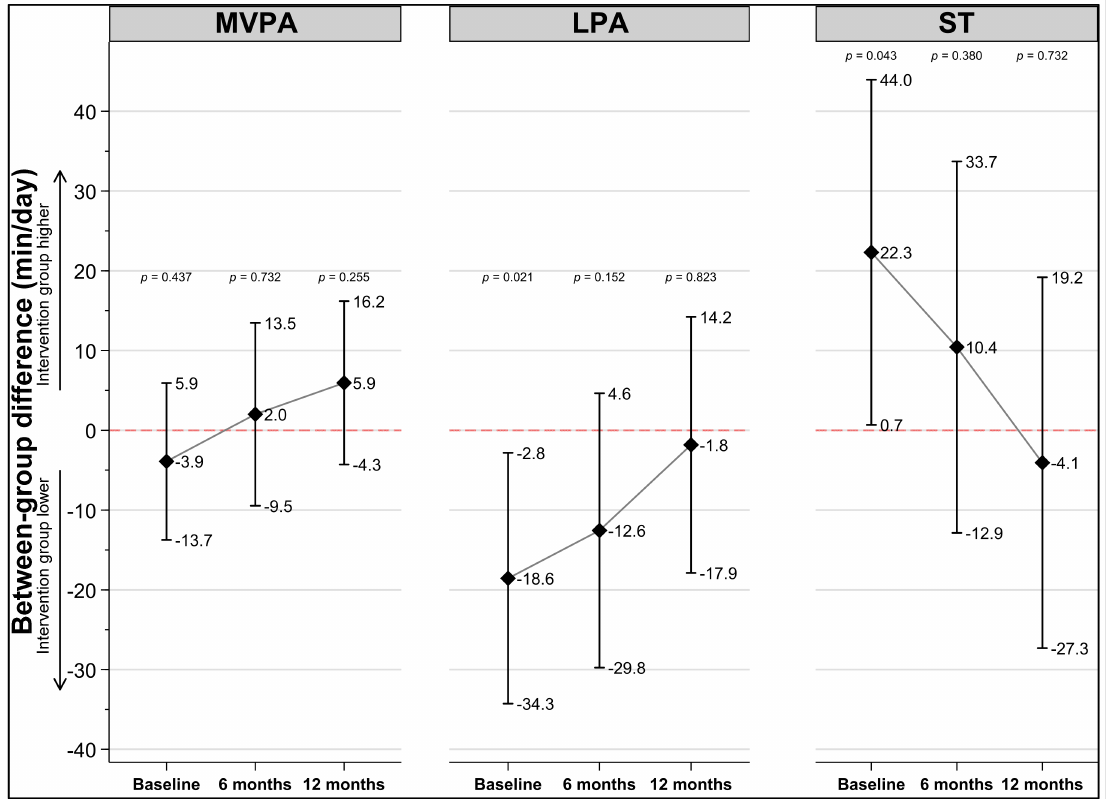
Figure 2. Between-group differences in physical activity and sedentary time from baseline to 12-month follow-up. Adjusted for sex and accelerometer wear time. Abbreviations; MVPA = moderate to vigorous physical activity; LPA = light physical activity; ST = sedentary